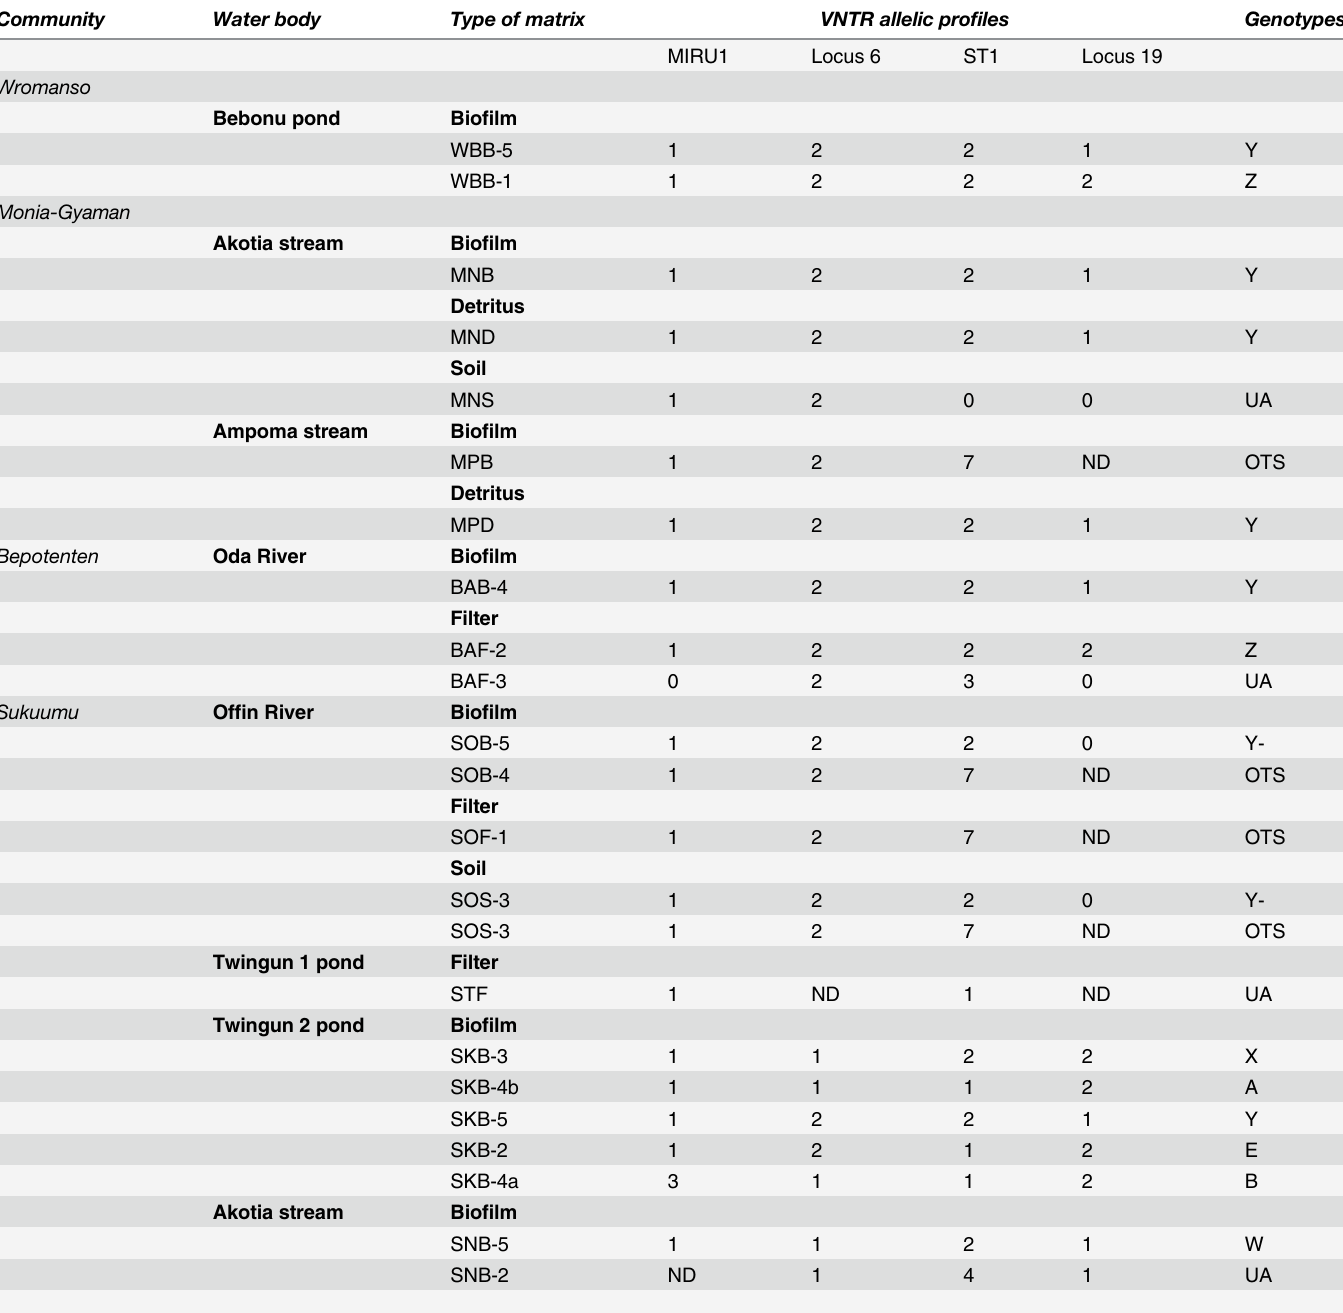
Table 3. VNTR analysis of environmental